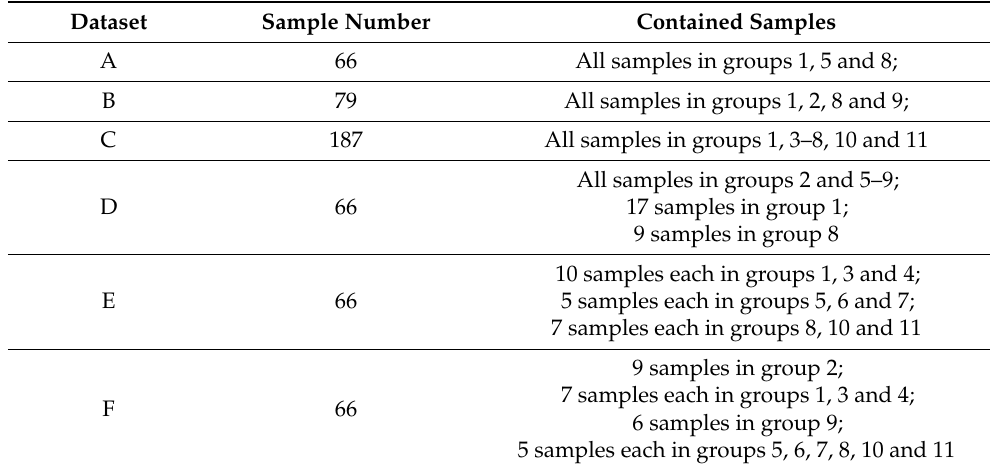
Table 2. Sample numbers and samples contained in different